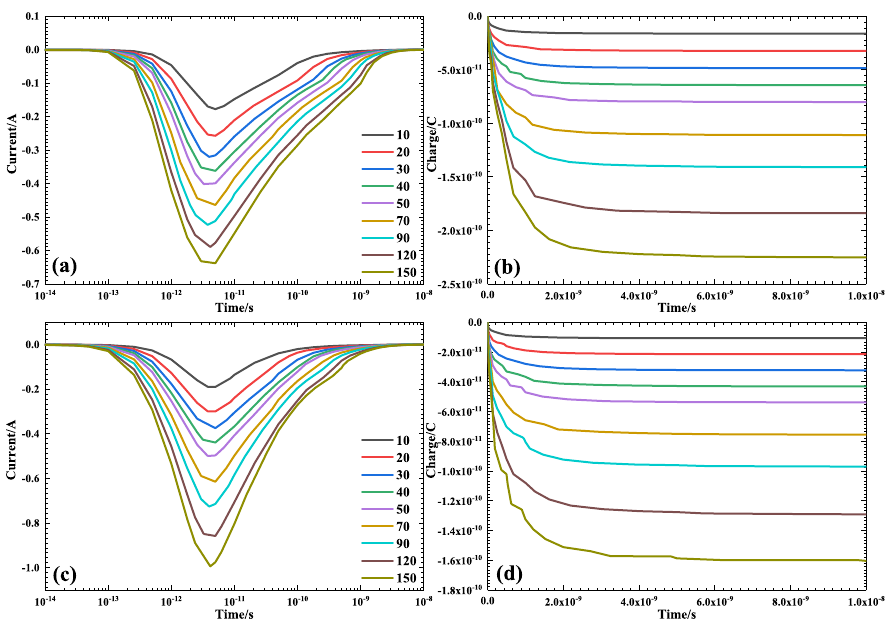
Figure 8. Change in base current and collected charge with time when heavy ions with different LET values vertically irradiate the emitter ( a , b ) and base ( c , d ) of the SiGe HBT.